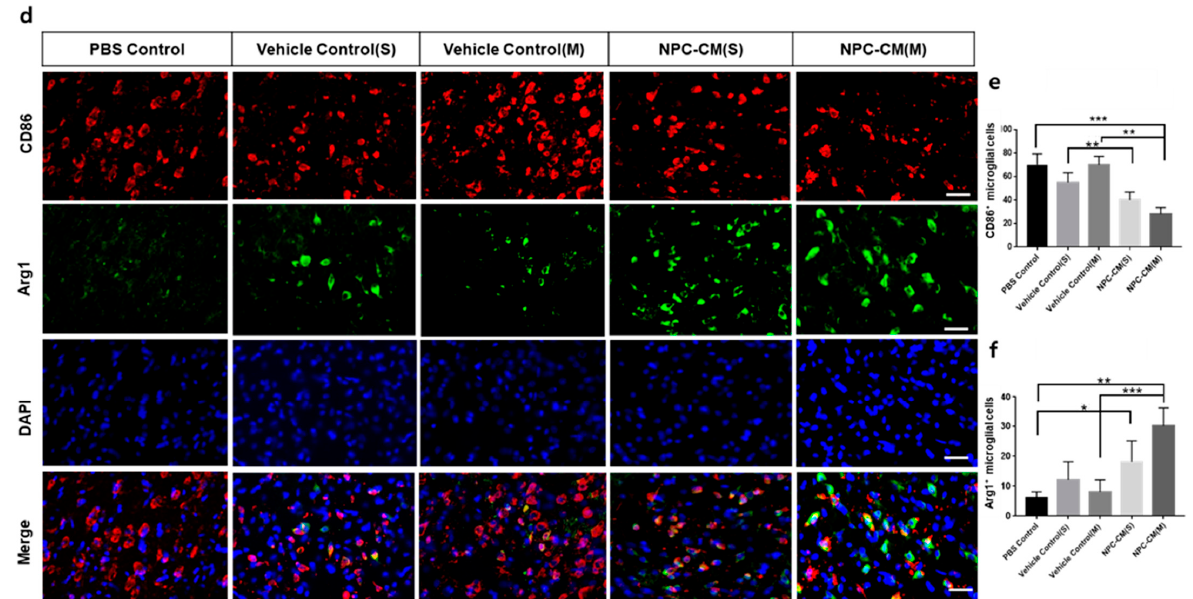
Figure 3. NPC-CM treatment reduced the levels of reactive glia cells at the ischemic lesion in the pMCAO. ( a ) Immunohistochemistry for ED-1 (top) and GFAP (bottom) of the brain from 15 days after pMCAO. Detail of the boxed area showing the astrocyte. ( b ) The expression levels of ED-1 immunostaining in the ischemic brain were reduced in NPC-CM(S) and NPC-CM(M). ( c ) GFAP immunoreactivity in reactive astrocytes at the peri-infarct area of the ipsilateral striatum was significantly decreased in response to NPC-CM(S) and NPC-CM(M) in comparison with those in the PBS control, Vehicle control(S), and Vehicle control(M). ( d ) M1 and M2 microglia in the ischemic lesion was assessed by immunohistochemistry with anti-CD86 and anti-Arg1 antibodies. Counts of CD86+ M1 microglial cells ( e ) and Arg1+ M2 microglial cells ( f ) per mm 2 in the SVZ ipsilateral to the ischemic injury are shown. Scale bar = 300 μ m. Values are indicated as means ± SD. * p ≤ 0.05, ** p ≤ 0.01, *** p ≤ 0.001.